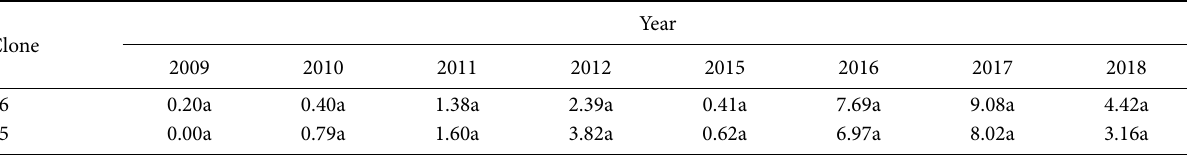
Table 1. Proportion (%) of grapevines displaying esca symptoms during August of eight years within the study plot, for Chardonnay clones 76 and 95. Statistically significant differences of expression ( P < 0.05) between clones within each year are indicated by different letters.